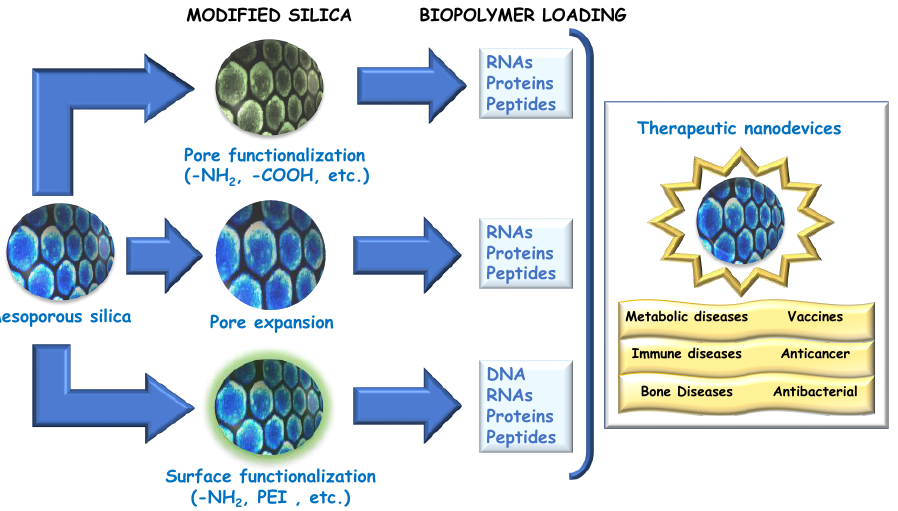
Figure 1. Workflow for building silica-based therapeutics for reviewed diseases. Different bioactive macromolecules could be incorporated onto the silica and efficiently dosed by properly engineering particles porous structure and surfaces.